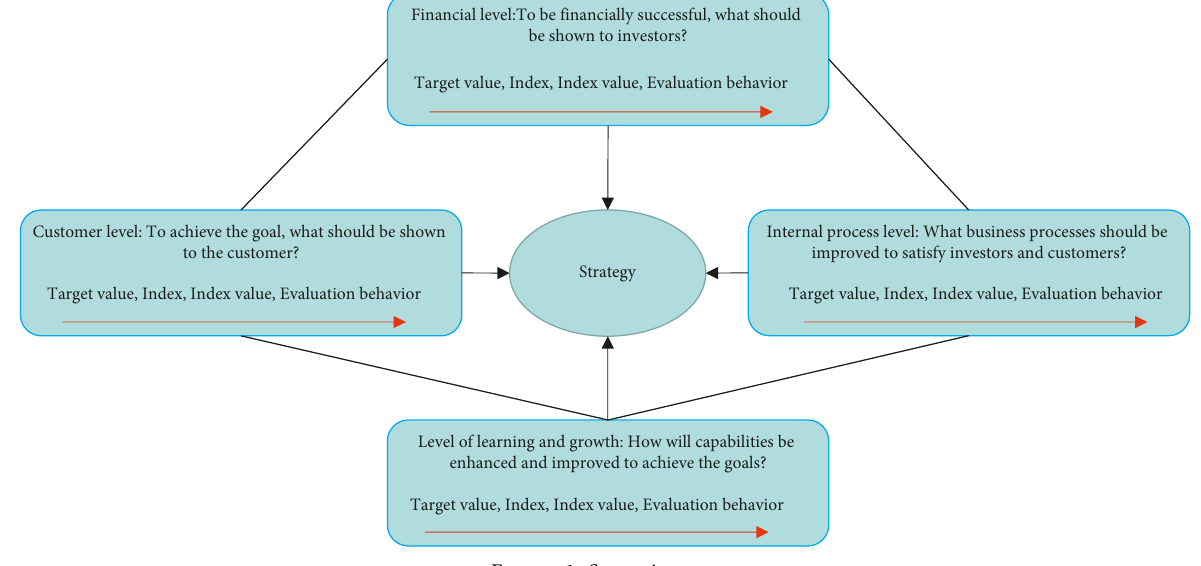
Figure 1: Strategic